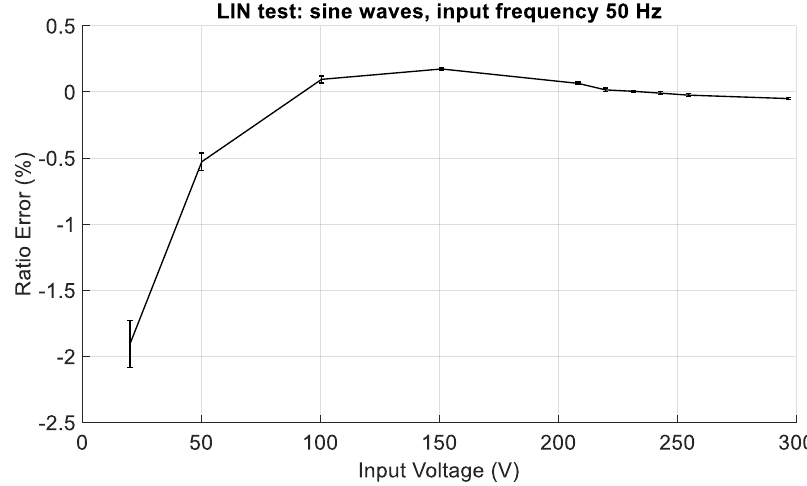
Figure 13. Ratio error in the LIN tests, with sinusoidal input voltage with frequency of 50 Hz and amplitudes from 20 V to 295 V